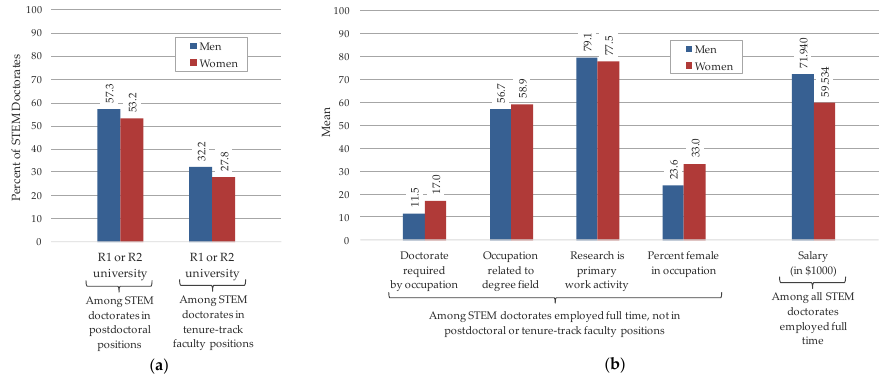
Figure 3. Gender-specific means for the variables measuring the characteristics of occupations entered by STEM doctorates who are employed full time: ( a ) the percent of STEM doctorates who attain postdoctoral or tenure-track faculty positions at R1 or R2 universities; and ( b ) salary, and the degree to which an occupation requires doctorate-level education, is closely related the doctorate’s degree field, demands research skills, and is female-dominated. Source : Author’s calculations using data from the Survey of Doctorate Recipients [22] and the O*NET Occupational Information Network Database [23], 1995–2013. Note: All gender differences are significant at α =